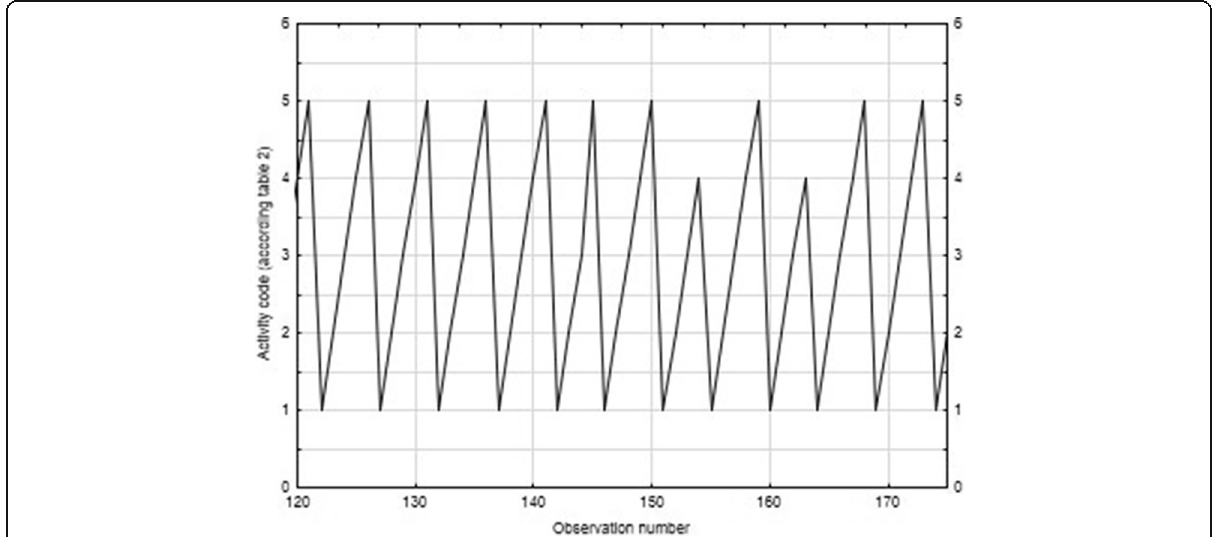
Fig. 2 Fragment of a time series of operations performed by a harvester in thinned